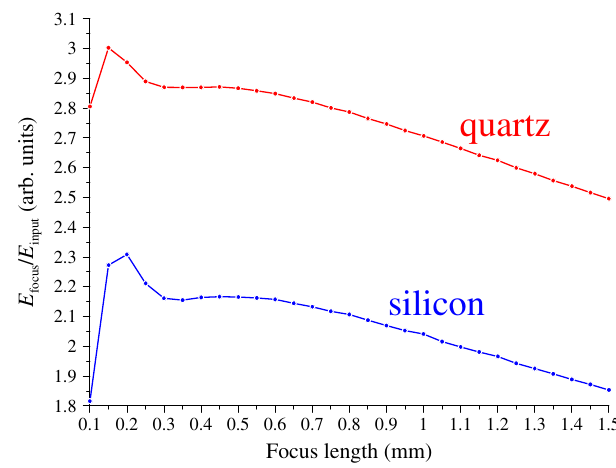
FIG. 5. Field enhancement at the focal plane of the lens for different lens materials. Red dashes are for quartz and blue for